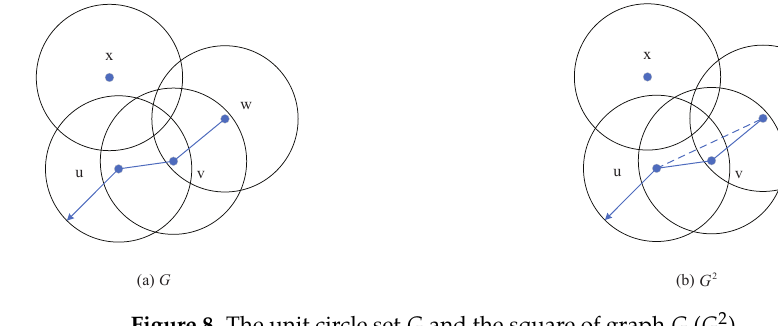
Figure 8. The unit circle set G and the square of graph G ( G 2